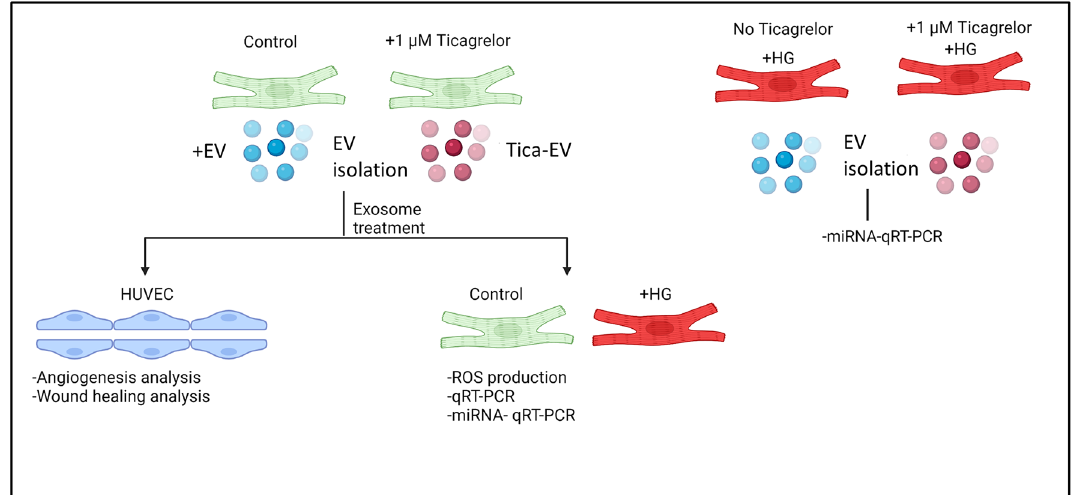
Figure 8. The followed experimental model and protocols in the present study. The Diabetes model was mimicked using the H9c2 cell line. EVs derived from ticagrelor treated and untreated H9c2 cells were analyzed at the functional and molecular levels. The image was drawn using BioRender (https:// biore nder.